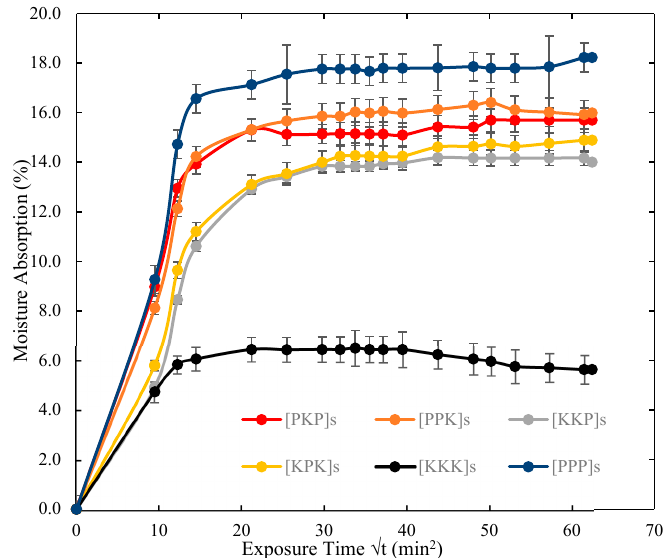
Figure 4. Moisture absorption characteristics of PALF/Kevlar ‐ reinforced UP hybrid composite laminates with various stacking sequences. Table 3. Summary of moisture absorption characteristics of PALF/Kevlar ‐ reinforced UP hybrid composites. Hybrid Laminate